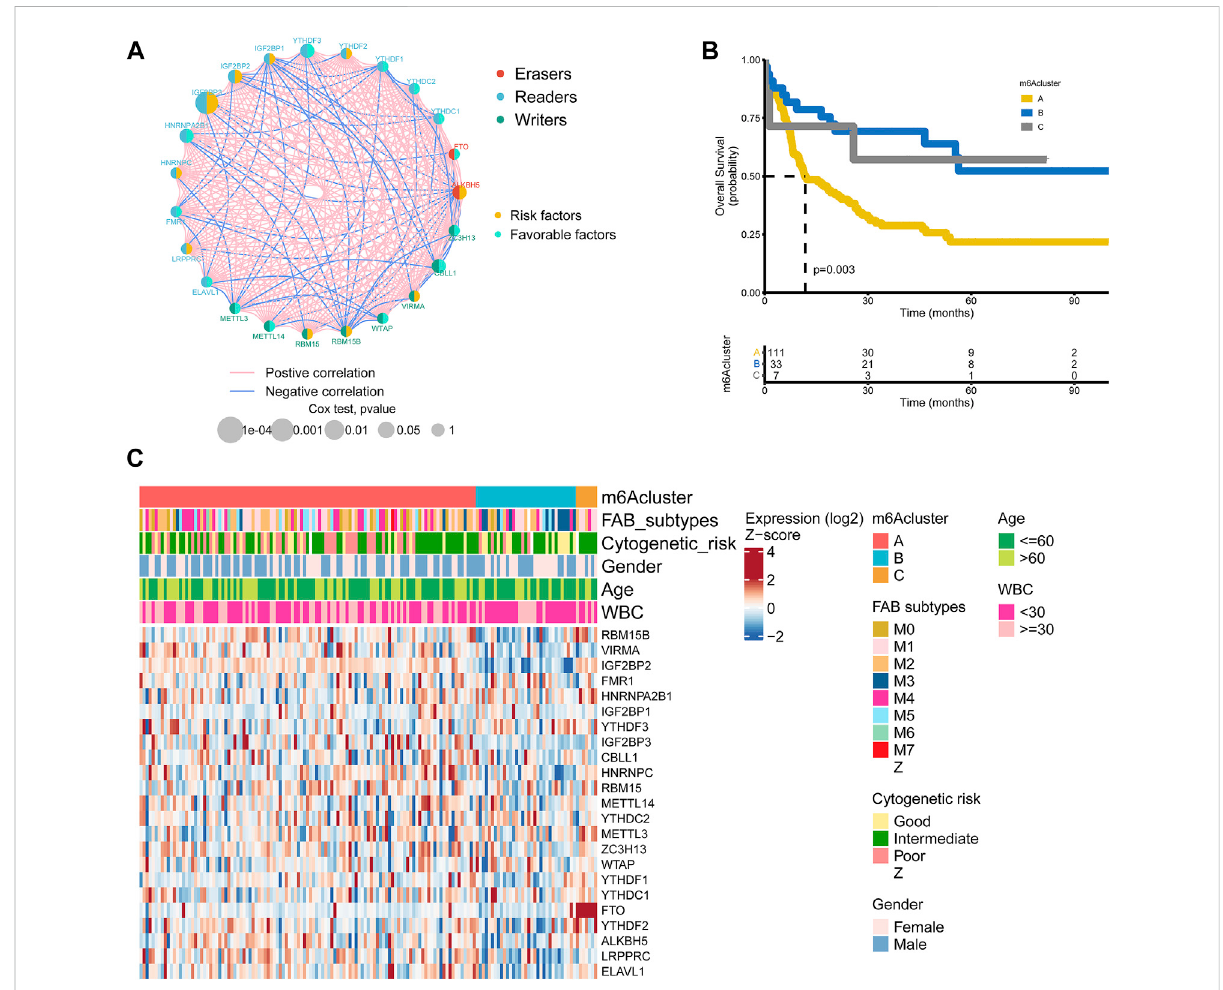
m6A regulators subtypes and their clinicopathological characteristics in AML (A) The interaction among m6A regulators in AML. The lines represented their interactions between regulators, and the thickness of lines showed the strength of the correlation. Effects of regulators on the prognosis were represented with the circle size, and p -values were calculated by Log-rank test ( p < 1, p < 0.05, p < 0.01, p < 0.001, P < 1e-04) (B) Kaplan-Meier overall survival curves of 111 cases in m6A cluster A, 33 cases in m6A cluster B, and 7 cases in m6A cluster C from the TCGA AML cohort (C) Differences in clinicopathological characteristics and expression levels of m6A among the three distinct m6A clusters. The m6A cluster, FAB subtypes, cytogenetic risk, gender, age, and WBC were used as patient